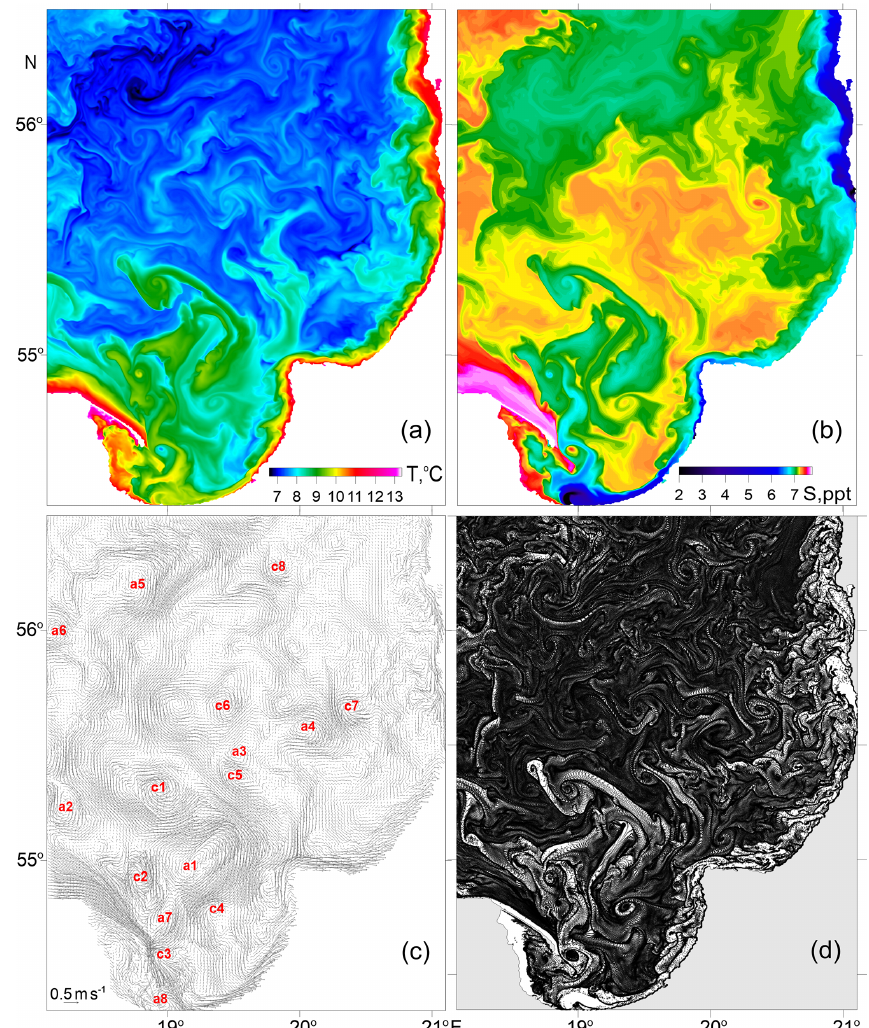
Figure 4. Modeled fields of the surface layer parameters in the southeastern Baltic Sea on 15 May 2015, 12:00UTC: temperature (a) , salinity (b) , current velocity (c) and spatial distribution of uniformly released synthetic floating Lagrangian particles (d) after 1d of advection. The red labels in panel (c) point at the cyclonic (c1, c2, etc.) and anticyclonic (a1, a2, etc.) eddies used to calculate the rotary characteristics in Sect. 3.4 (see Table